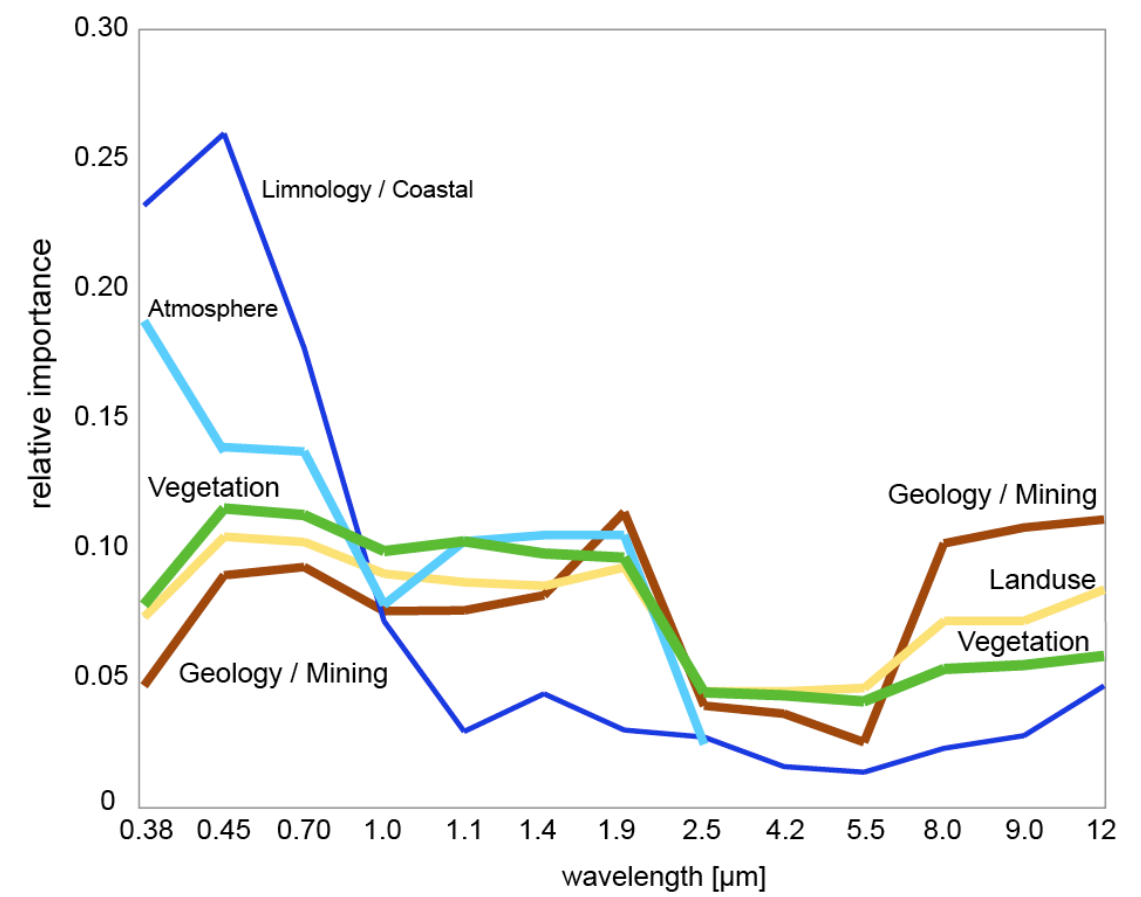
Figure 4. Relative importance of spectral ranges for different HSI data